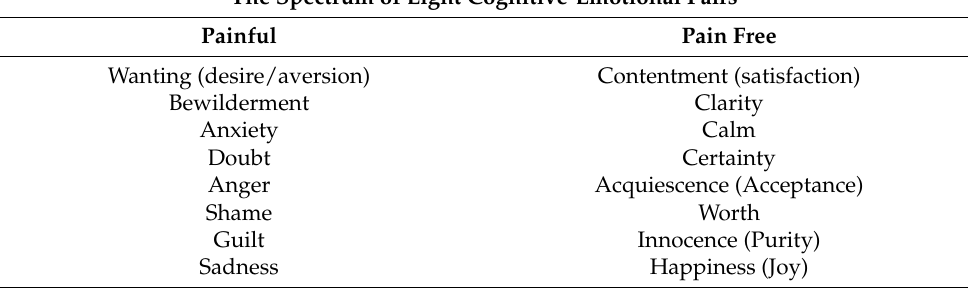
Table 1. Adapted from Culliford [27] (p.